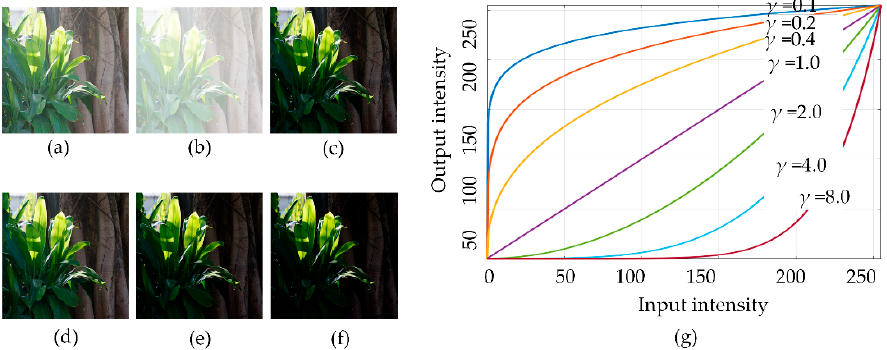
Figure 1. An example of gamma correction, the enhanced images with different parameters γ . ( a ) Original image. ( b ) γ = 0.1. ( c ) γ = 0.3. ( d ) γ =0.8. ( e ) γ = 1.2. ( f ) γ = 1.5. ( g ) The curve along with different parameters γ .